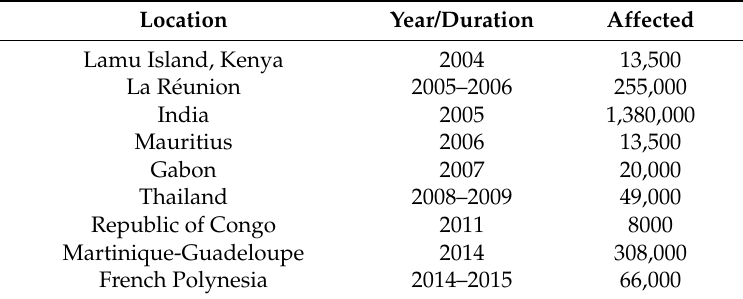
Table 1. Recent selected large-scale CHIKV epidemics in the